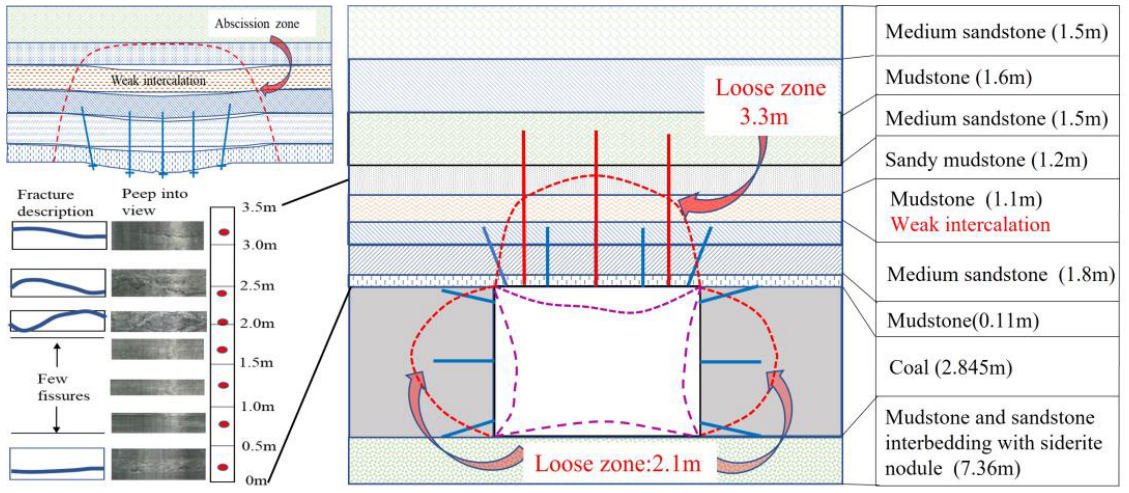
Figure 2. Survey Results.